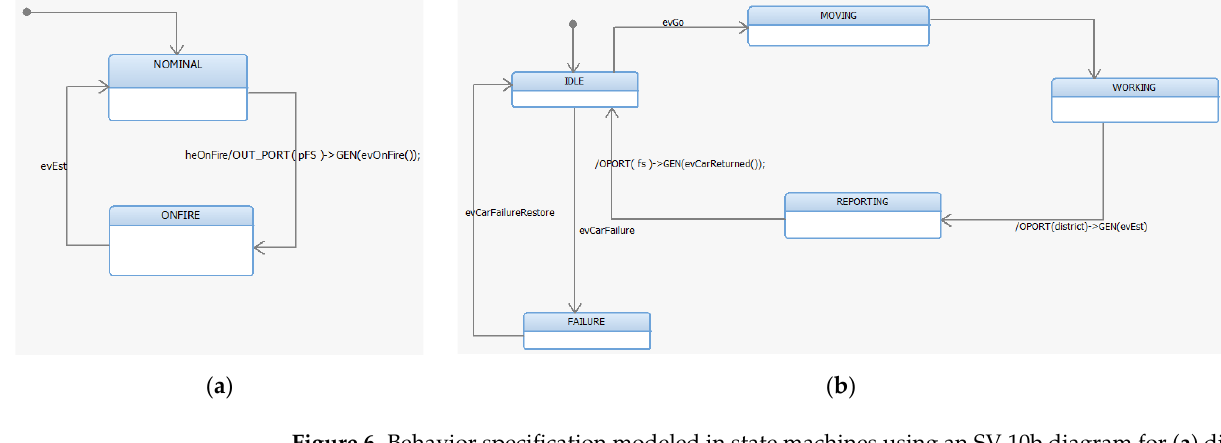
Figure 6. Behavior specification modeled in state machines using an SV ‐ 10b diagram for ( a ) district CS and ( b ) firefighting machine CS.